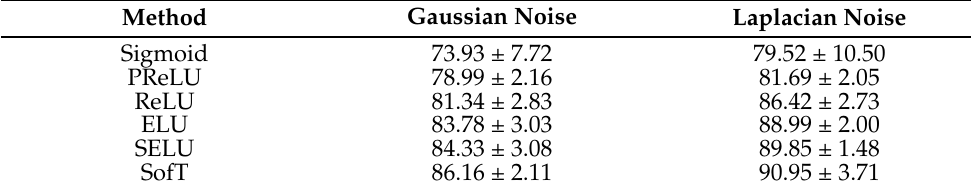
Table 4. The overall average accuracy of different activation functions